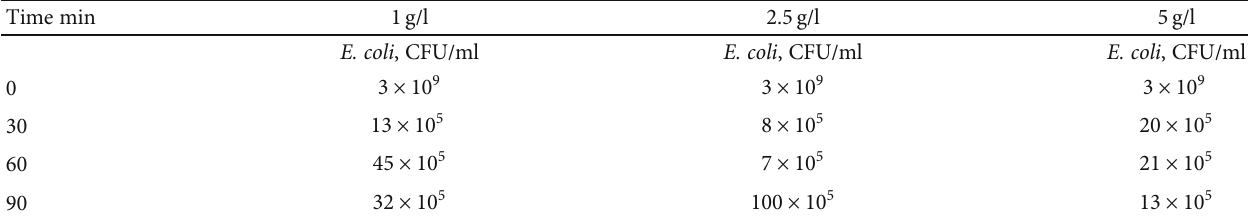
Table 2: Bacterial adsorption using di ff erent masses of the sample catalyst Cloi/TiCe0.5.